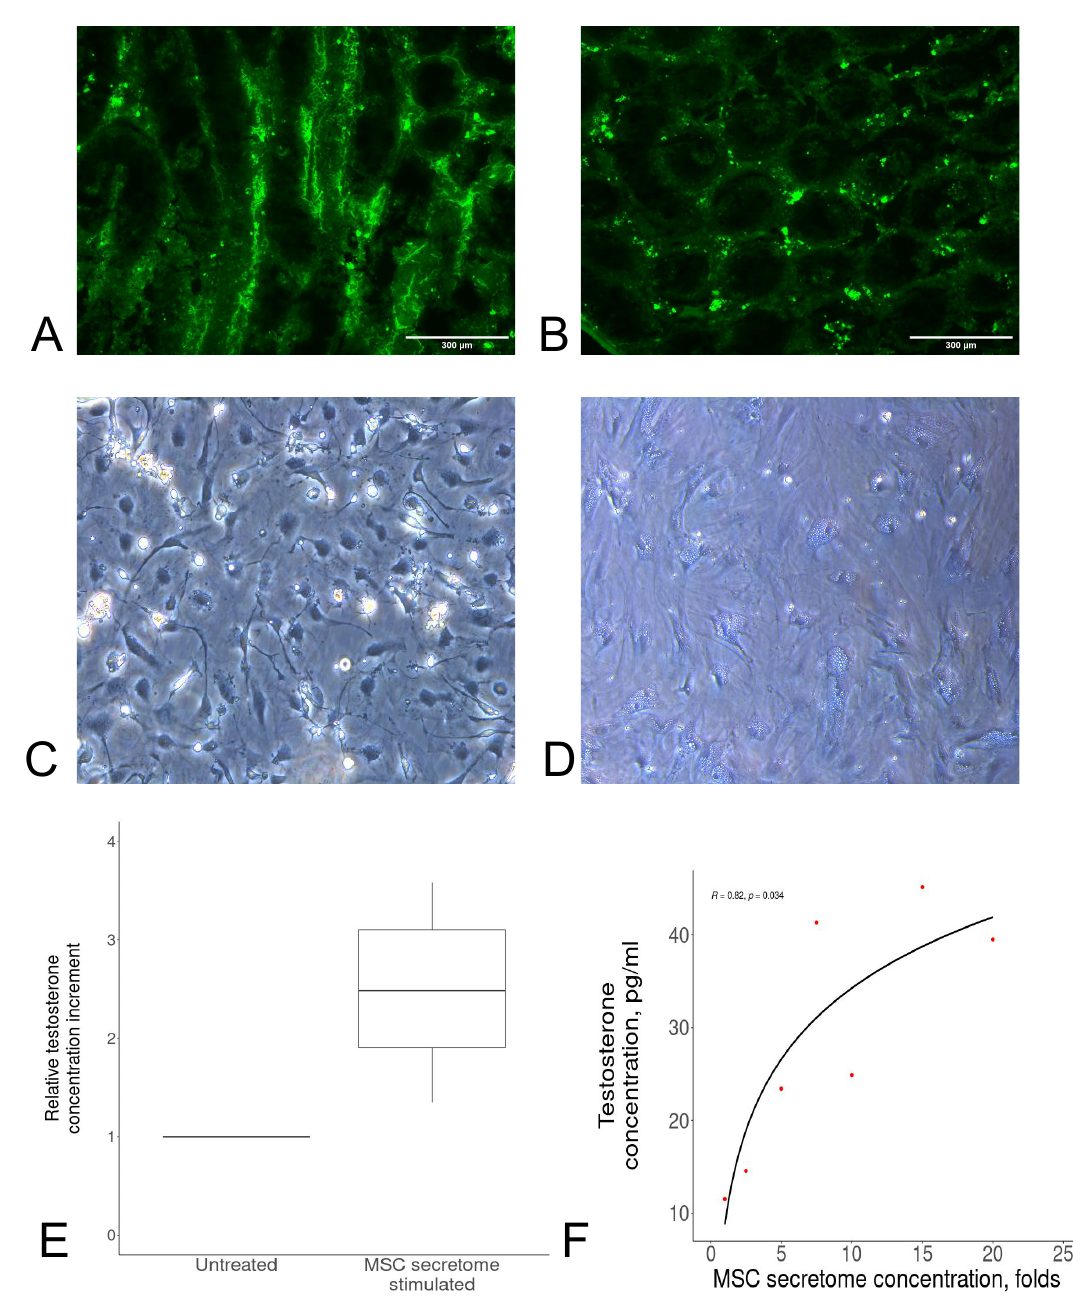
Figure 1. ( A , B ) The locally injected mock product was predominantly distributed outside sem- iniferous tubules: ( A ) collagen (control); ( B ) collagen + GFP. ( C , D ) Morphology of Leydig cells: ( C ) 24 h after isolation; ( D ) 96 h after isolation. ( E ) MSC secretome-stimulated Leydig cells se- creted more testosterone compared to untreated cells (the value of their potency was equal to one). Data are presented as the median, 25th and 75th percentiles, and minimum and maximum values. ( F ) Testosterone secretion by Leydig cells was directly associated with the MSC secretome concentra- tion; the correlation was calculated using Spearman’s test (R = 0.82, p = 0.034). Red dots indicate independent